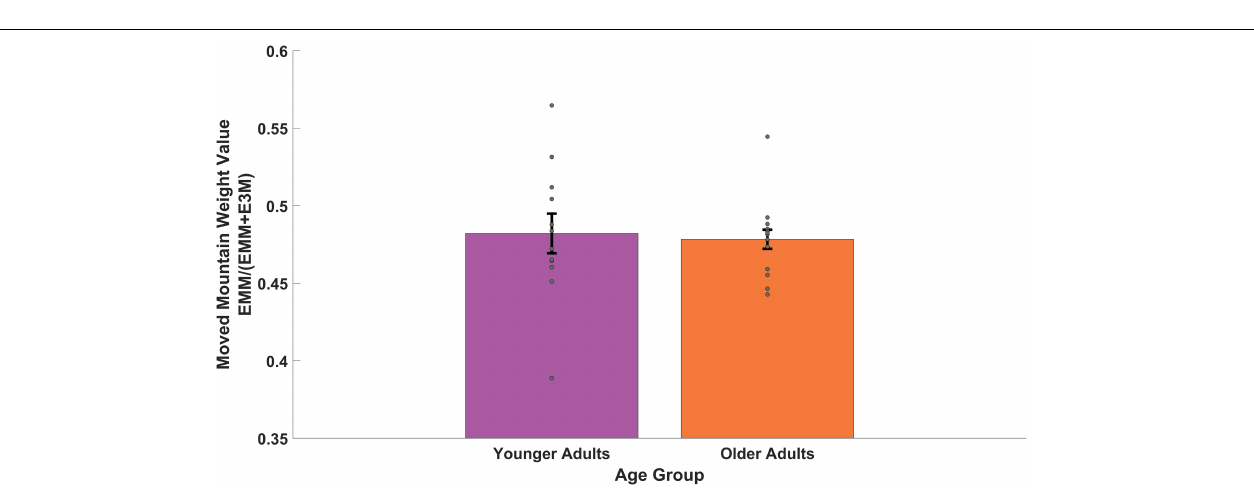
FIGURE 6 | Memory for the target during trials in which one distal cue moved. EMM (see Section 3.5) provides a relative weighting of allocentric vs. beacon cues by assuming the memory for the target moves with the mountain and dividing it by the same distance + the target’s unmoved location. Values less than 0.5 would favor moving with the mountain and values larger than 0.5 would favor utilizing the 3 distal